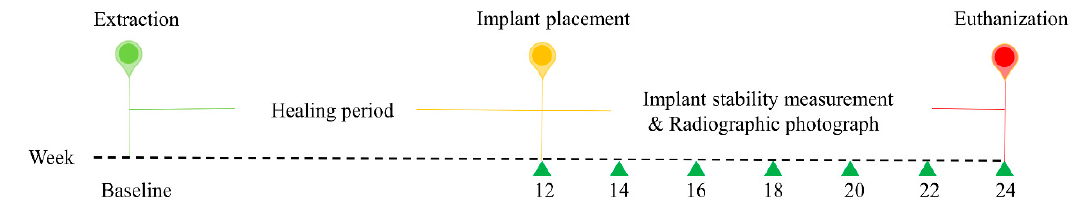
Figure 1. Outline of the experiment. At baseline, the second, third, and fourth premolars and first molars were extracted from the left and right sides of the mandible. After 12 weeks, three different implants were randomly placed in the healing ridges.